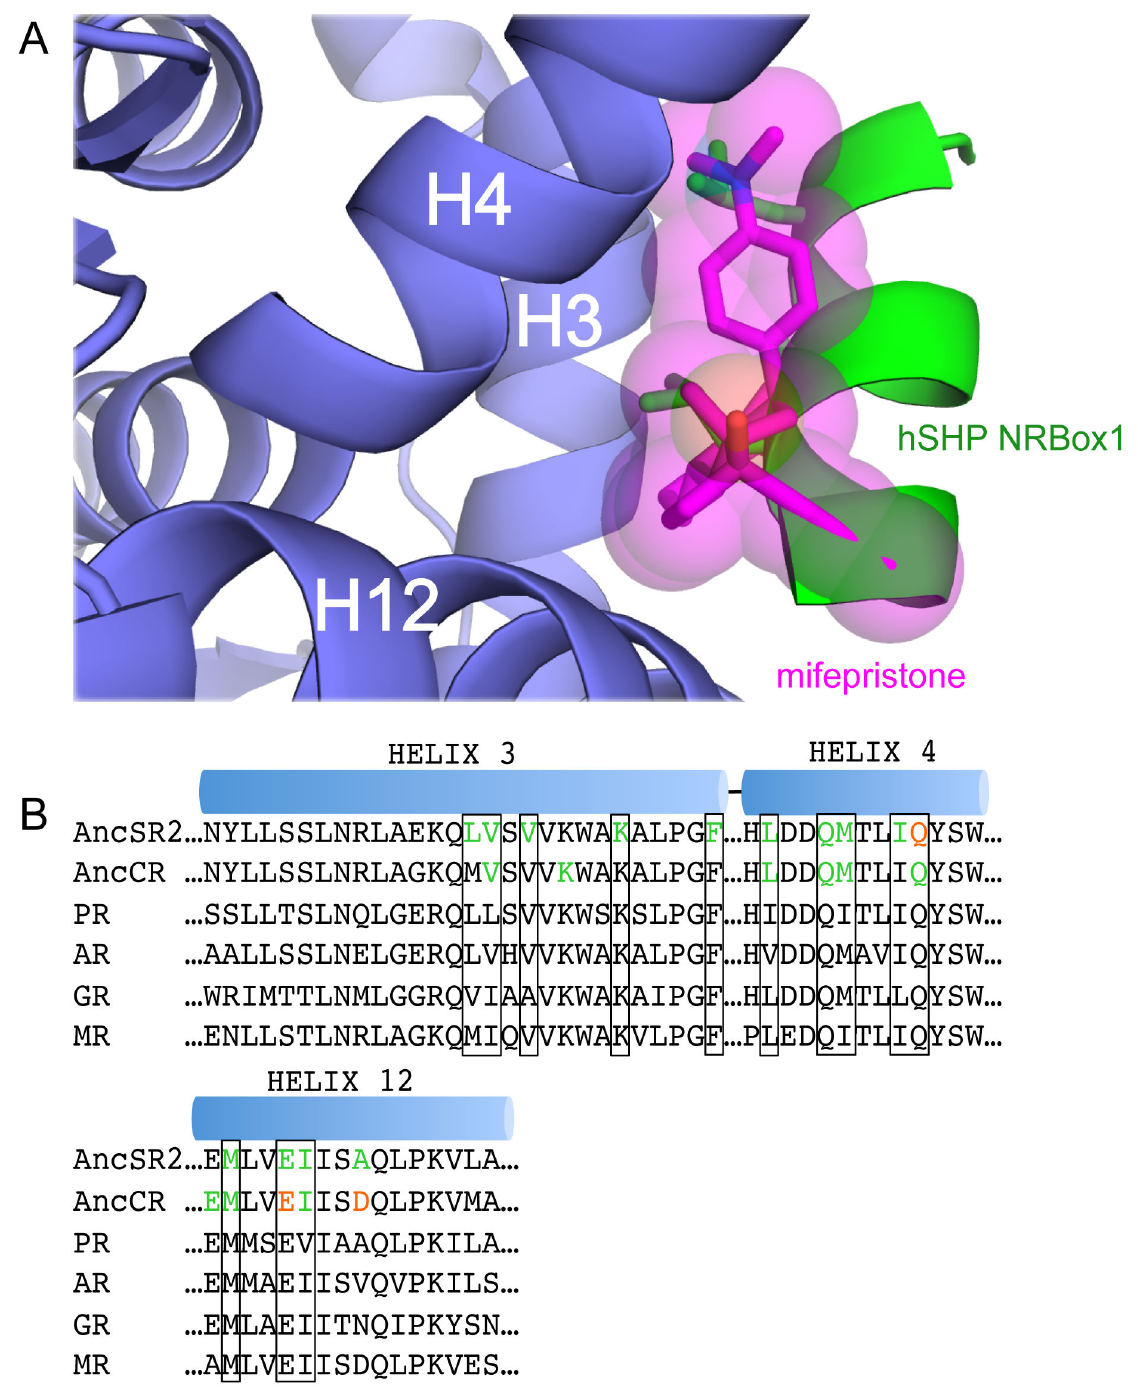
Figure 5. Mifepristone occupies the coactivator protein space. A. ancSR2–progesterone–mifepristone (protein, slate blue; mifepristone, magenta) was overlaid with ancestral corticoid receptor–deoxycorticosterone–hSHP NRBox1 (PDB accession code: 2Q3Y) complex. Mifepristone occupies the same space as the hSHP NRBox1 peptide (green, leucine side chains shown as sticks). B. Sequence alignment of ancestral and extant 3-ketosteroid receptor coactivator binding clefts . Sequence alignments of the AncSR2, AncCR, Progesterone Receptor (PR), Androgen Receptor (AR), Glucocorticoid Receptor (GR), and Mineralocorticoid Receptor (MR) coactivator binding clefts. Hydrophobic interactions (green) and hydrogen bonds (red) are shown for the interaction between AncSR2–mifepristone site-two and AncCR–SHP. Conserved residues across the SR lineage are indicated by a black box. doi: 10.1371/journal.pone.0080761.g005 PLOS ONE |